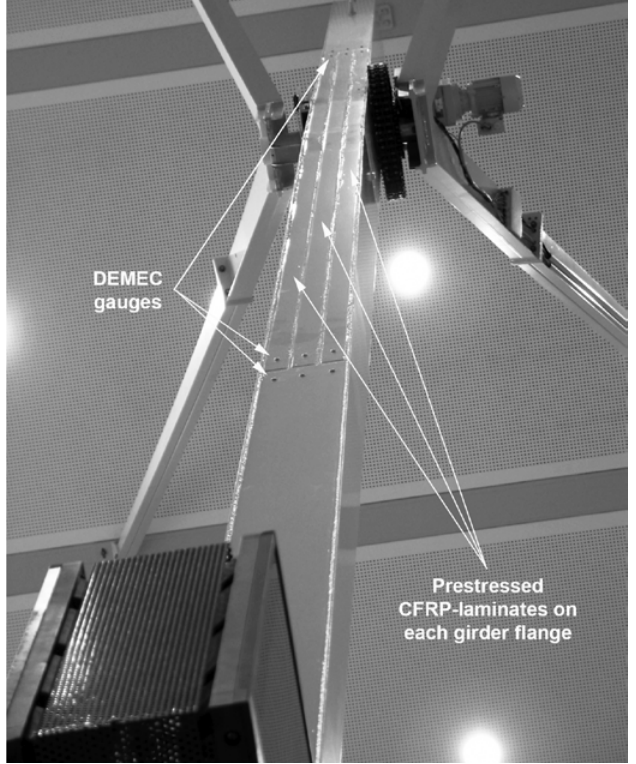
Figure 13. Six prestressed CFRP laminates on the flanges of the artwork